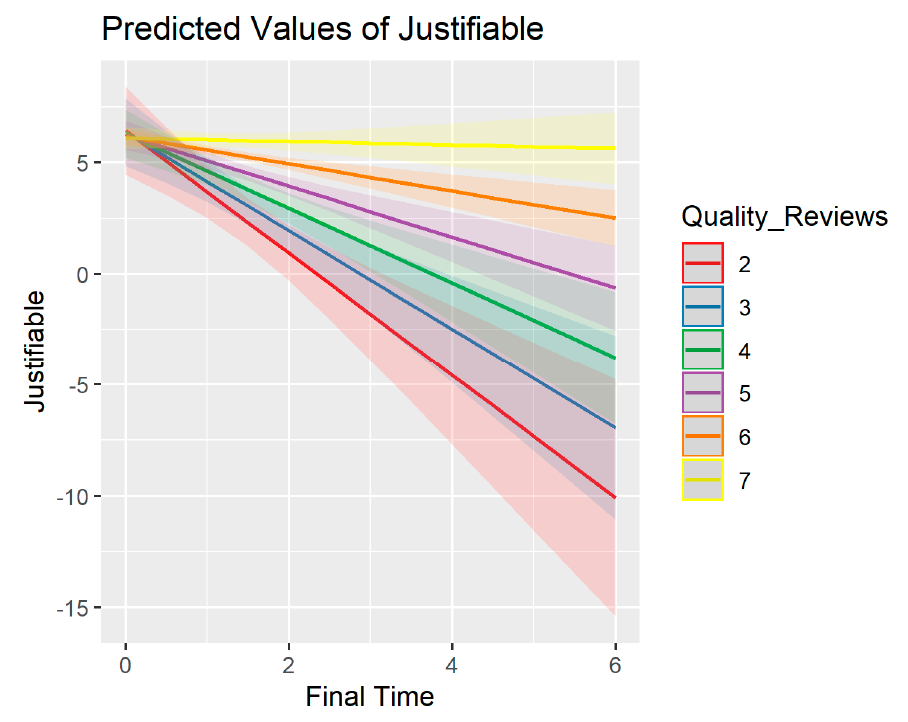
Figure 1. Review quality as a moderator of the relationship between publishing time and publishing time justifiability.